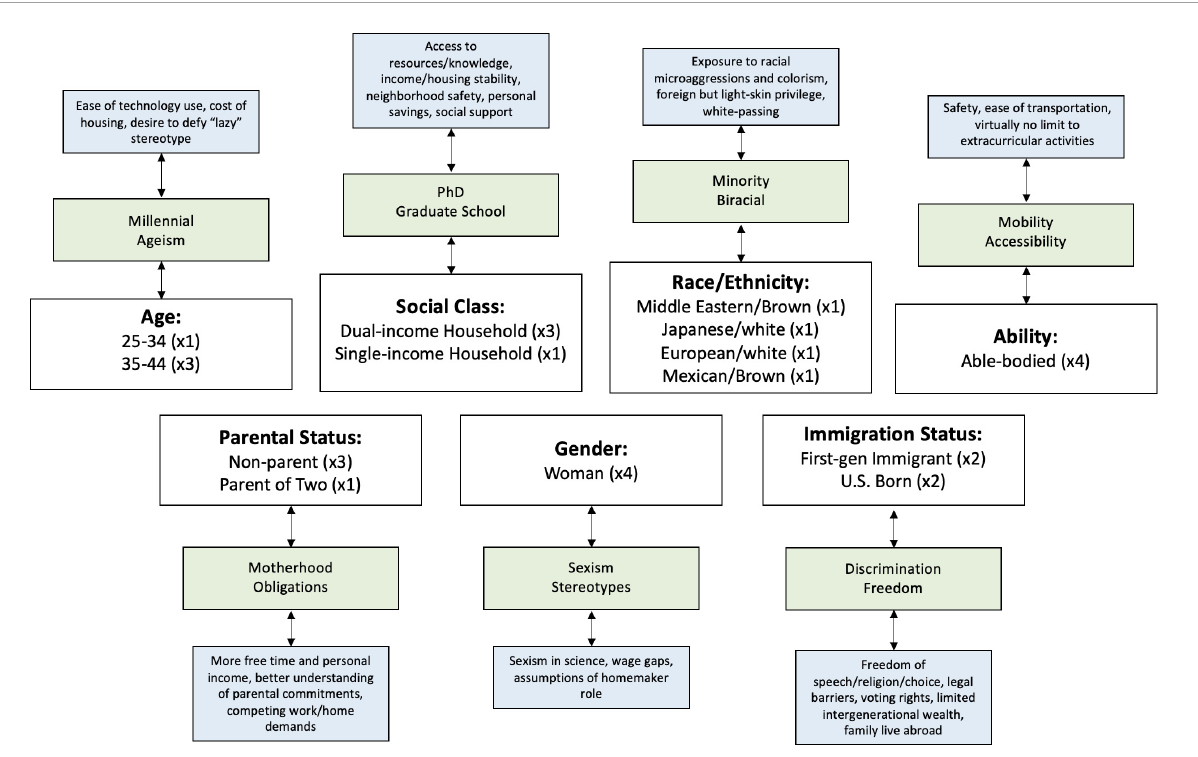
FIGURE1 Positionality map. Tier 1 (white boxes) represents the identity categories selected for the current study (with a number representing how many individuals share a particular identity). Tier 2 (green boxes) specifies how these identities impact our lives and Tier 3 (blue boxes) elaborates further on the particularities of these